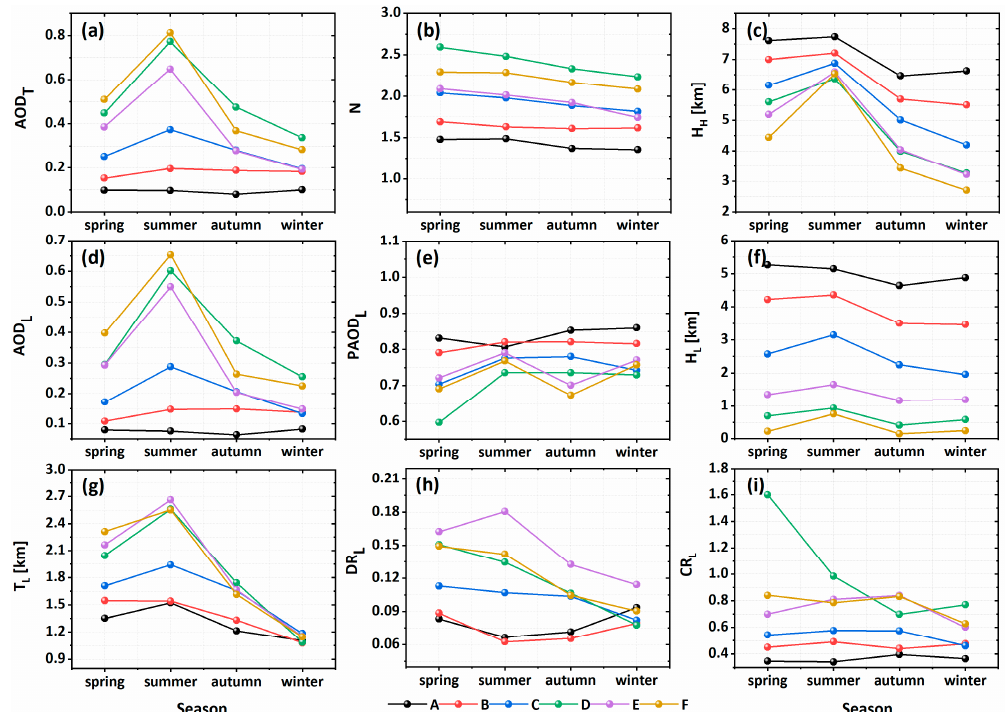
Figure 7. Seasonal variations in the optical characteristics of aerosol layers over Pakistan ( A : Gilgit- Baltistan, B : Jammu-Kashmir, C : Khyber-Pakhtunkhwa, D : Punjab, E : Balochistan, F : Sindh)